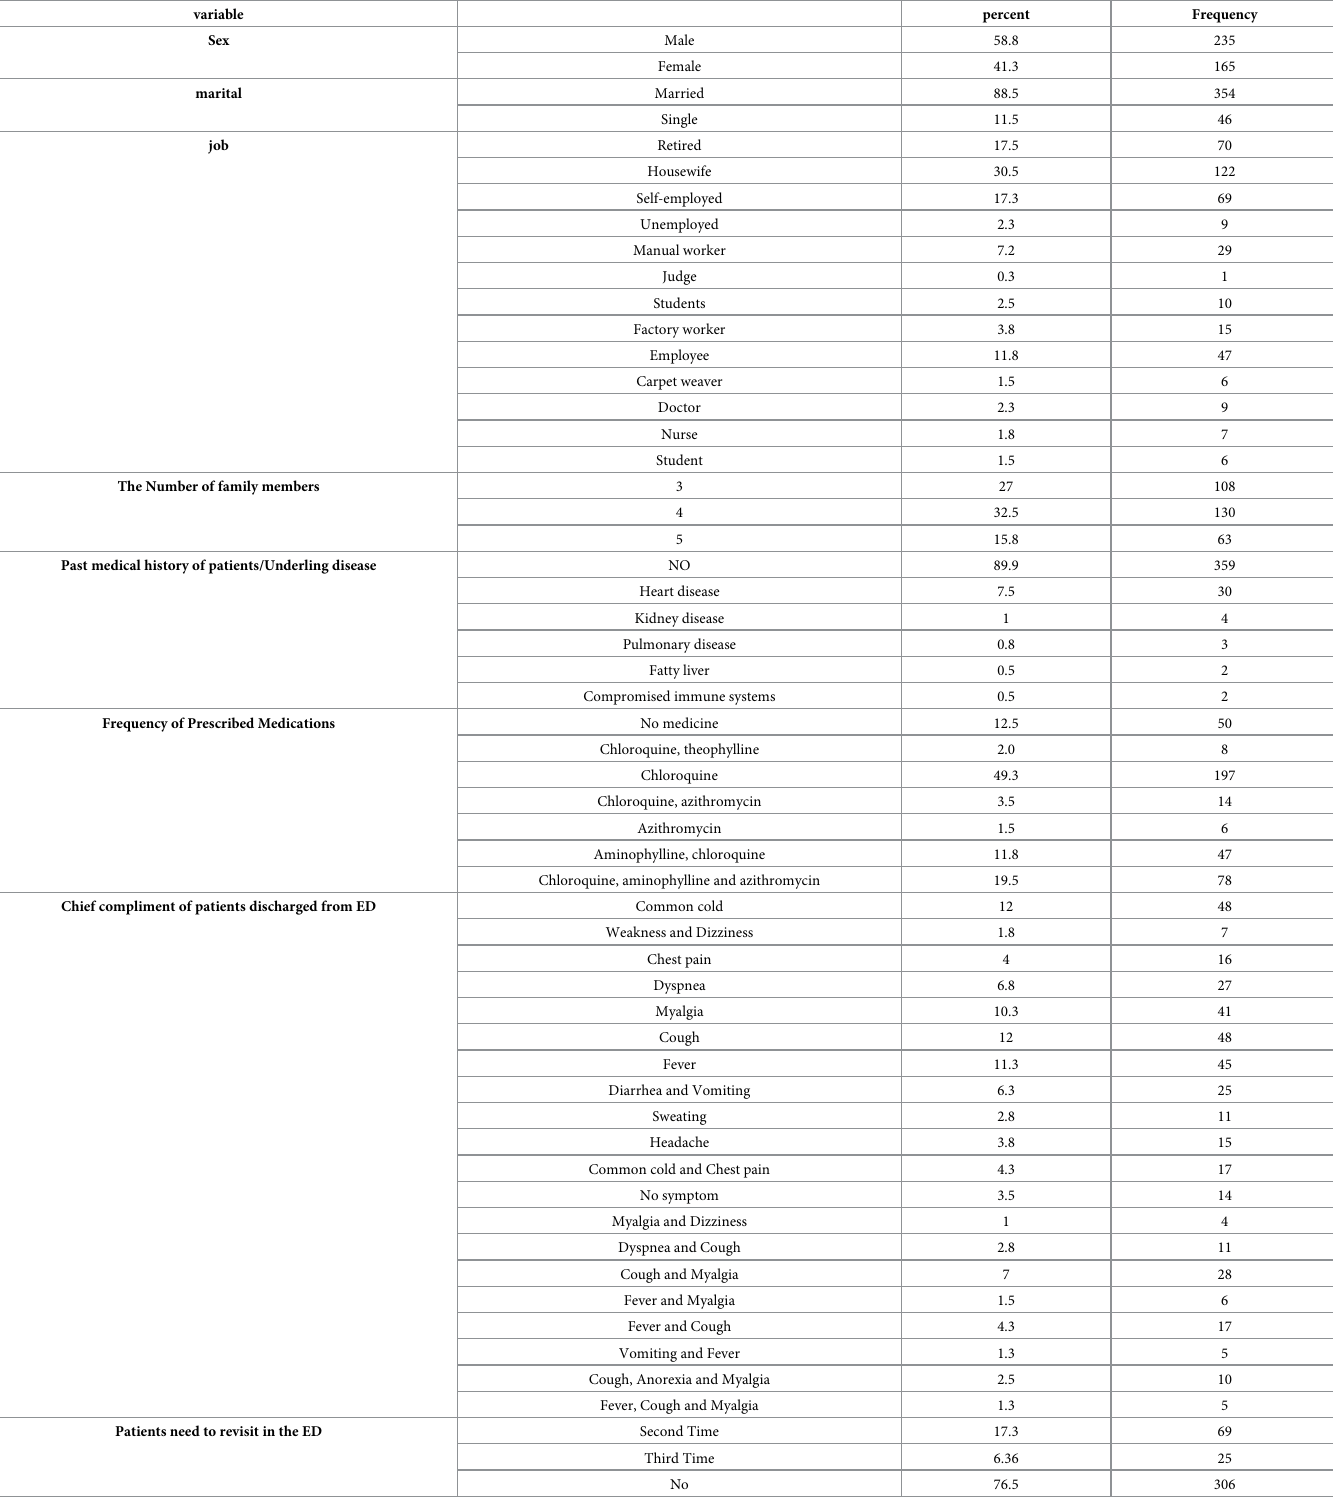
Table 1. Characteristics of the 400 included